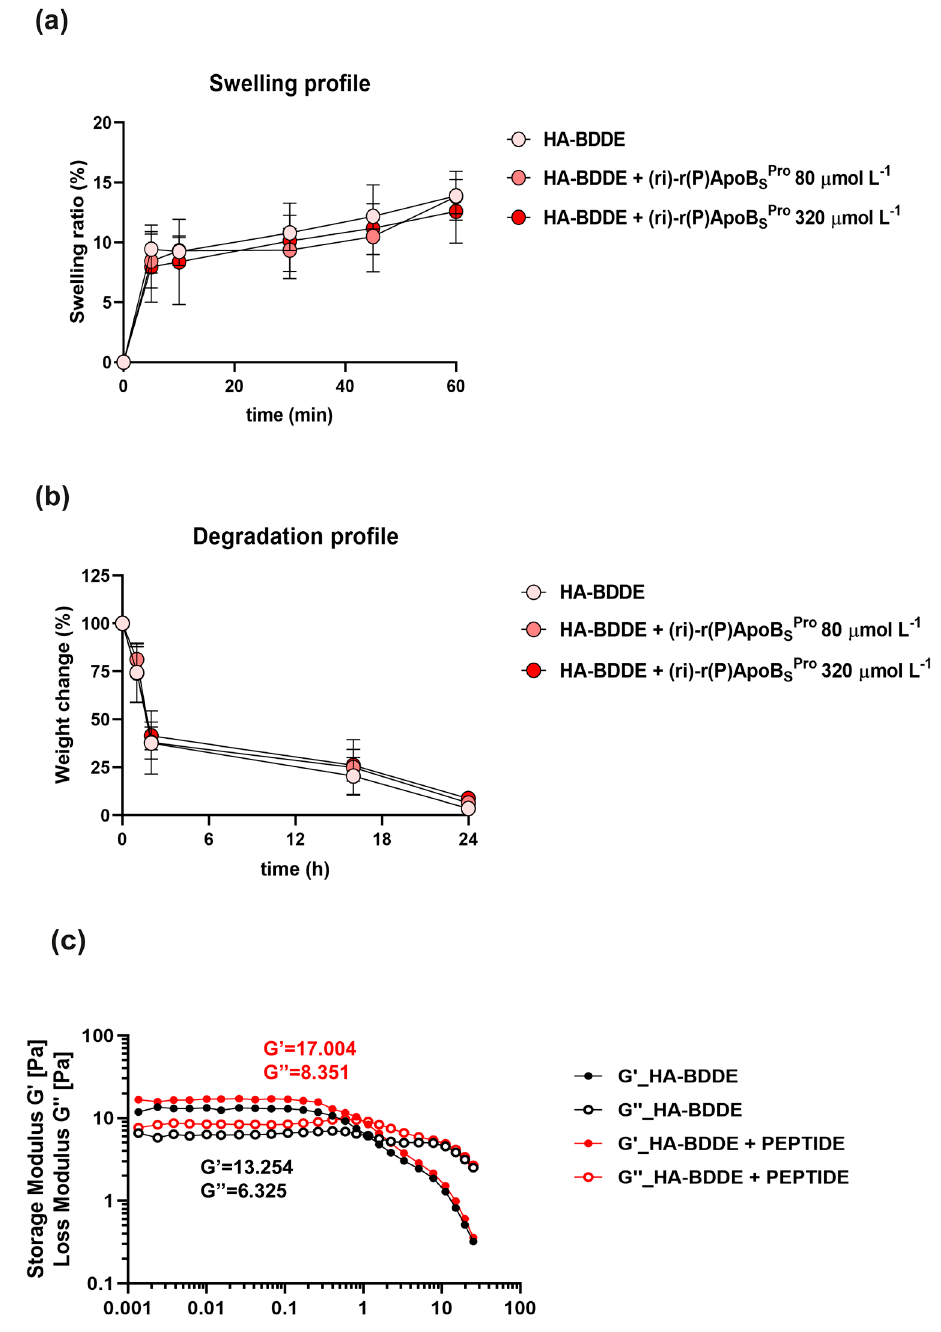
Figure 4. Physical and mechanical properties of the hydrogel-based system. Swelling ( a ) and degradation ( b ) profiles of HA-BDDE alone and loaded with two different concentrations of (ri)-r(P)ApoB SPro (80 or 320 µmol L − 1 ). ( c ) Rheological characterization of HA-BDDE hydrogel alone and loaded with (ri)-r(P)ApoB SPro peptidomimetic (320 µmol L − 1 ) based on the monitoring of elastic (G’) and viscous moduli (G”) as a function of shear stress. The values reported, 17.004 and 8.351, and 13.254 and 6.326 for G’ and G”, respectively, are the parameters obtained for each sample in the linear viscous